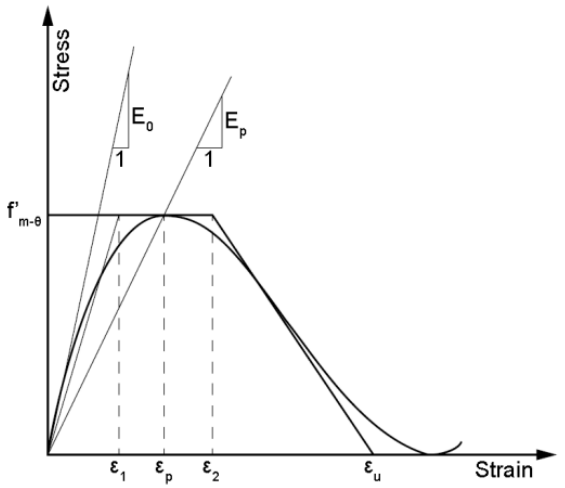
Figure 9. Simplified stress-strain tri-linear relation (adapted from Ref. [9]). Asteris (2008) developed a 2D finite element approach proposing a new methodology to account for the contact and separation between the frame and the infill walls [267]. The frame was modelled with plane beam elements and the masonry infill with an isoparametric rectangular element with eight degrees of freedom. When the load is applied, it begins with the infill element connected to one of the nodes of frame column-beam connections, and then, an iterative process is initiated in order to rerun the analysis until the infill element is not overlapping with the frame elements. Another check is then performed in order to assess the separation of infill-frame according to which, if tensions are computed on those connections, then the points are not linked. Tabeshpour (2009) recommended bounds for the width of the equivalent strut, shown in Table 7